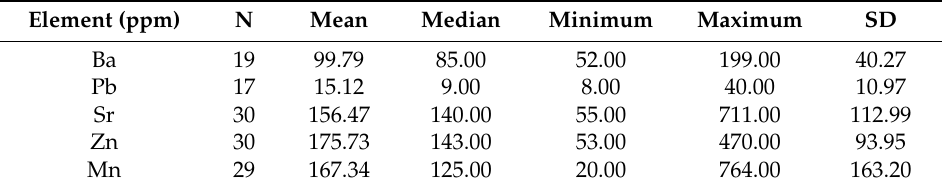
Table 2. Concentrations of the examined elements in the hard tissues (bones and teeth together) of ruminant species from the West Carpathians.